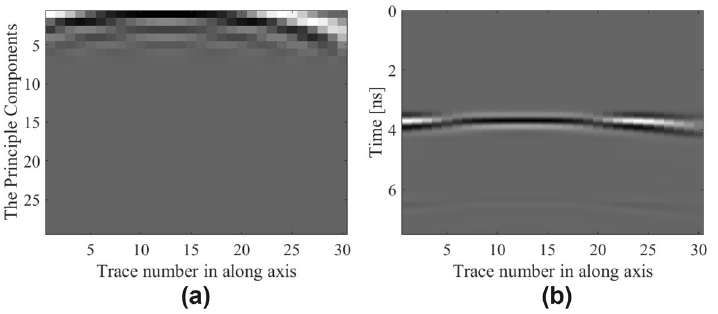
Figure 10. A sample test scenario corresponding to D = 276 mm, P = 172 mm, and R = 33 mm: ( a ) extracted principle component features by using PCA; ( b ) pre-processed (clutter reduced) B-scan image by using